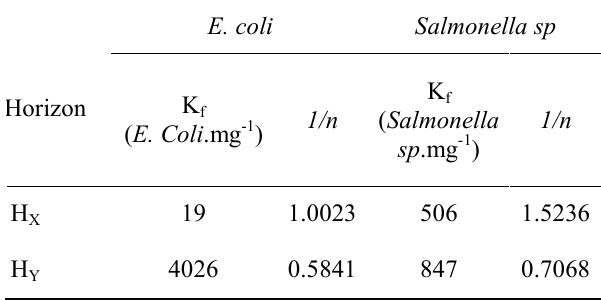
Table 1: Adsorption coefficient (K